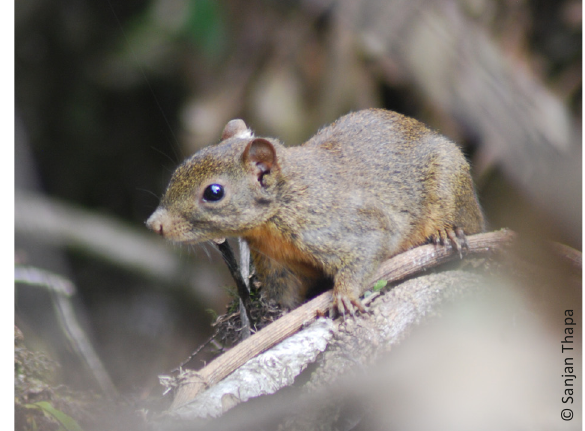
Image 1. Orange-bellied Himalayan Squirrel Dremomys lokriah